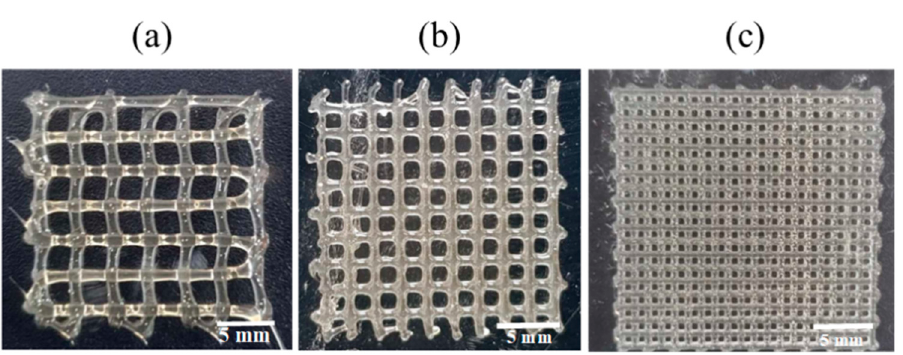
Table 3. Printing accuracy and fiber characteristics of MCL-PHA terpolyester scaffolds fabricated using 3D-printing at the operation temperature of 130 °C with 3 mm/s of printing speed.